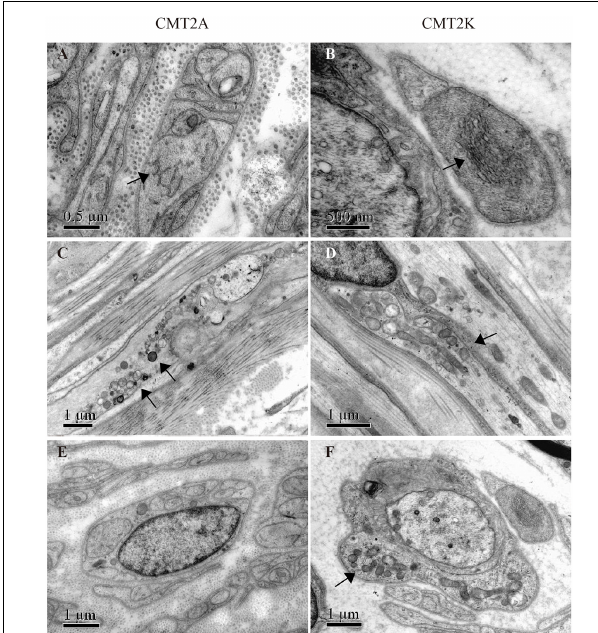
FIGURE 3 | Mitochondrial morphology in mitofusin 2 (MFN2)- and ganglioside-induced differentiation-associated protein 1 (GDAP1)-related CMT. (A,B) Closely packed, irregularly oriented neurofilaments in axons of unmyelinated nerve fibers (arrow) in CMT2A and CMT2K. (C) Abnormal aggregation of the round, small, and fragmented mitochondria in CMT2A (arrows). (D) Mitochondrial elongation and aggregation in CMT2K (arrow). (E) Scattered mitochondria in the Schwann cell of CMT2A. (F) Aggregation of mitochondria in the Schwann cell of CMT2K (arrow).